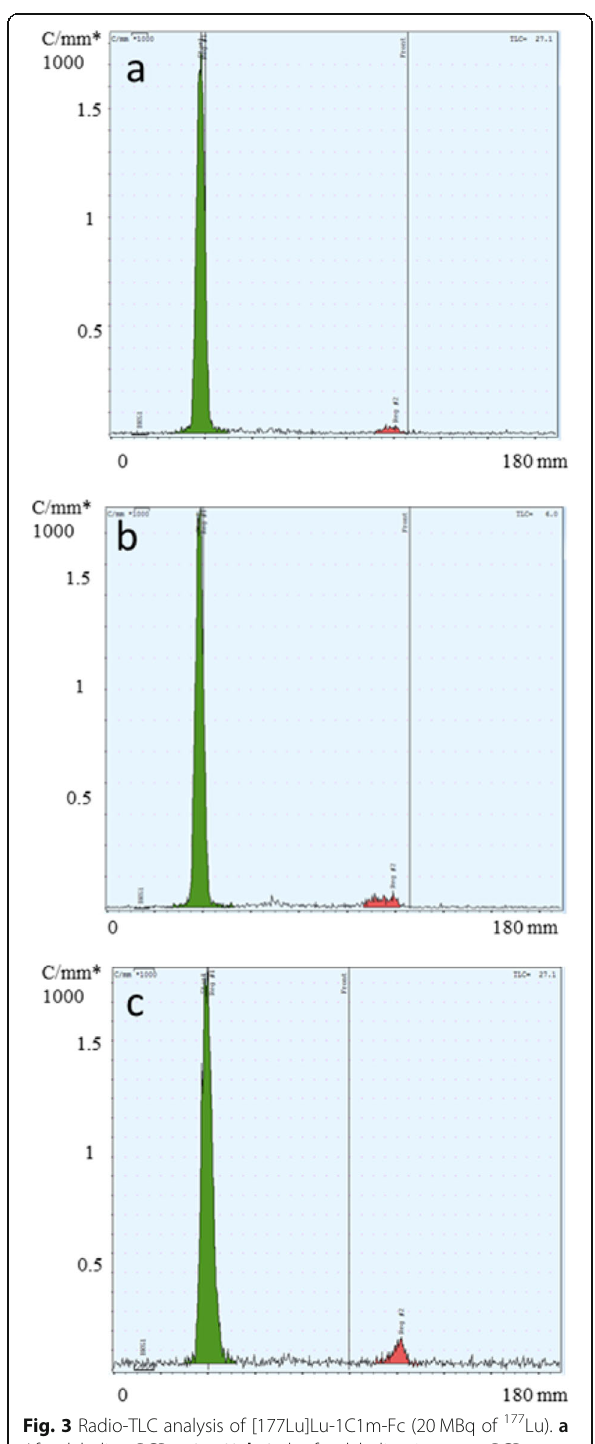
Fig. 3 Radio-TLC analysis of [177Lu]Lu-1C1m-Fc (20 MBq of 177 Lu). a After labeling RCP = 97.4%. b 24 h after labeling in serum RCP = 95.3%. c 48 h after labeling in serum RCP =